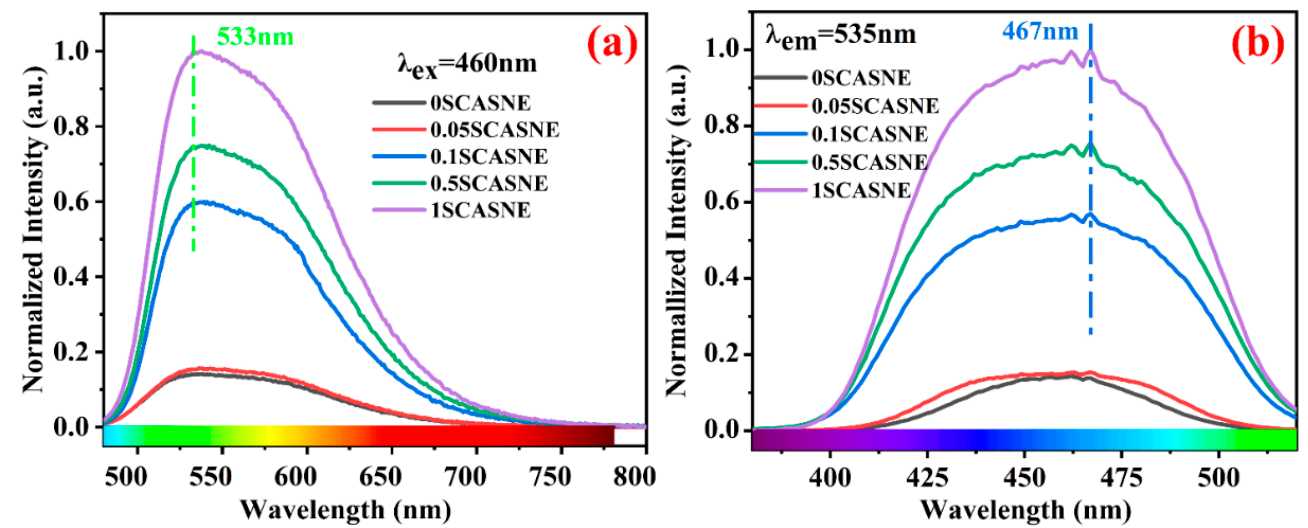
Figure 4. Normalized ( a ) PL and ( b ) PLE spectra of the prepared serial SCASNE phosphor ceramics. The quantum yield (QY) values of a series of SCASNE phosphor ceramics were studied and are provided in Figure 5. Under the excitation of 460 nm blue light, the QY values were 91.21%, 98.70%, 97.21%, 99.30%, and 97.80%, respectively, for a 0%, 0.05%, 0.1%, 0.5%, and 1% (Sr, Ca)AlSiN 3 :Eu 2+ phosphor-doping concentration. It was found that the QY of YAG:Ce 3+ matrix ceramics were greater than 90%, and (Sr, Ca)AlSiN 3 :Eu 2+ phosphor enhanced the YQ, due to a higher energy-transfer efficiency [36]. The maximum QY at a 0.5% doping concentration was 99.30%, and the corresponding sample was 0.5SCASNE. This demonstrated that (Sr, Ca)AlSiN 3 :Eu 2+ phosphor was competent as an efficient